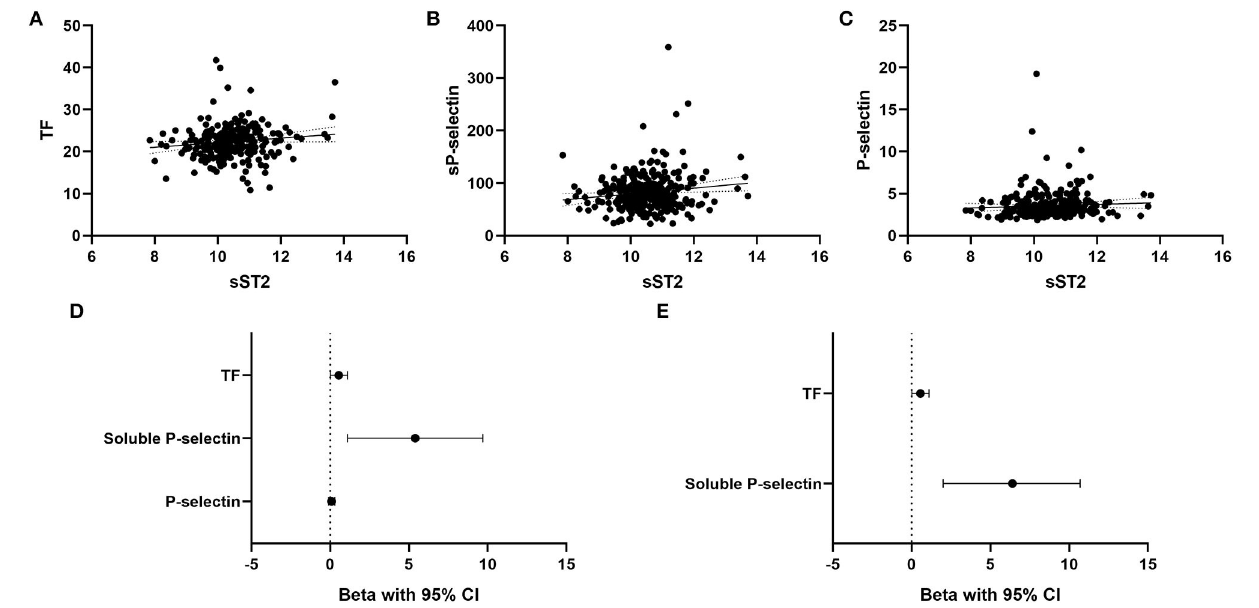
FIGURE 2 | Association of circulating sST2 with monocyte TF, soluble P-selectin, and platelet surface P-selectin. Univariate linear regression analysis for association of sST2 with monocyte TF (A) , soluble P-selectin (B) , and platelet surface P-selectin (C) was performed as described in the methods section. Forest plots depict the univariate (D) and multivariate (E) regression coefficients Beta with 95% confidence interval. The multivariate regression model was adjusted for age, sex, arterial hypertension, hyperlipidemia, active smoking, type 2 diabetes and high-sensitivity CRP. A p < 0.05 was considered statistically